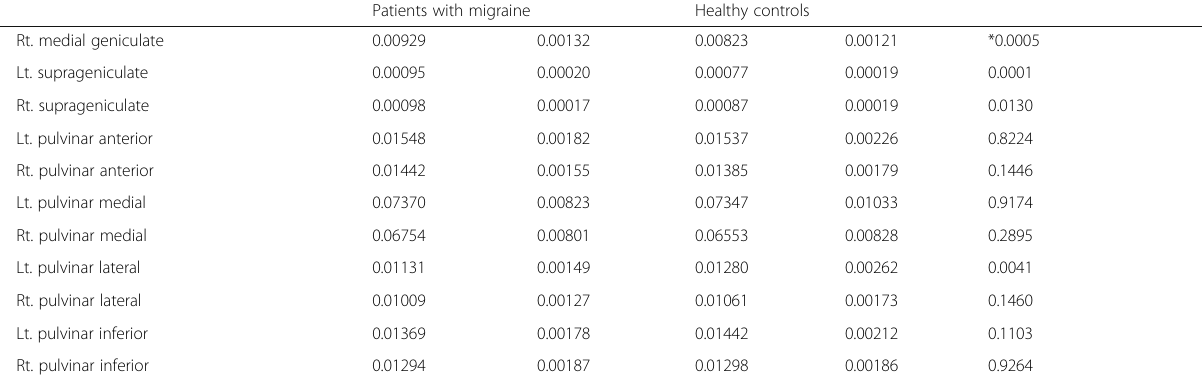
Table 2 Differences in the individual thalamic nuclei volumes between patients with migraine and healthy controls (Continued) Patients with migraine Healthy controls